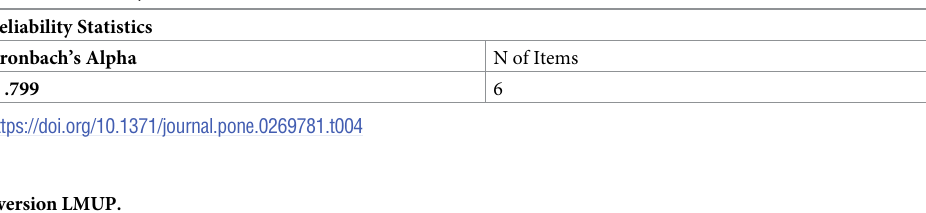
Table 4. Reliability statistics of Amharic version of LMUP.